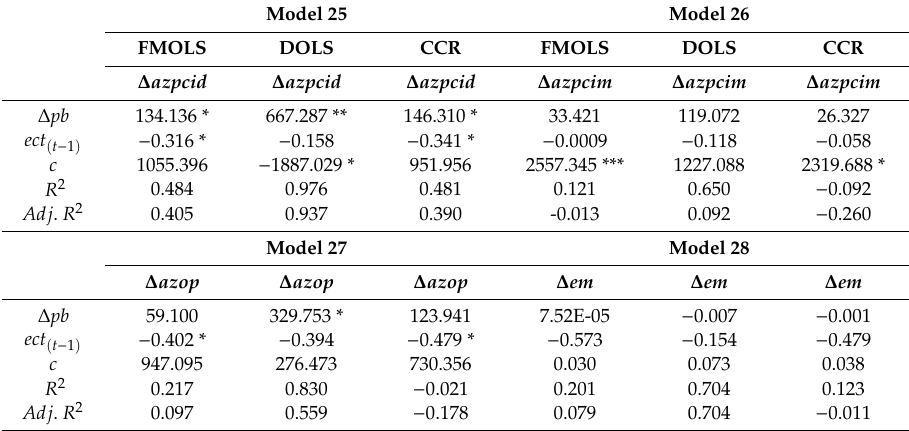
Table 14. The influence of oil price on macroeconomic indicators